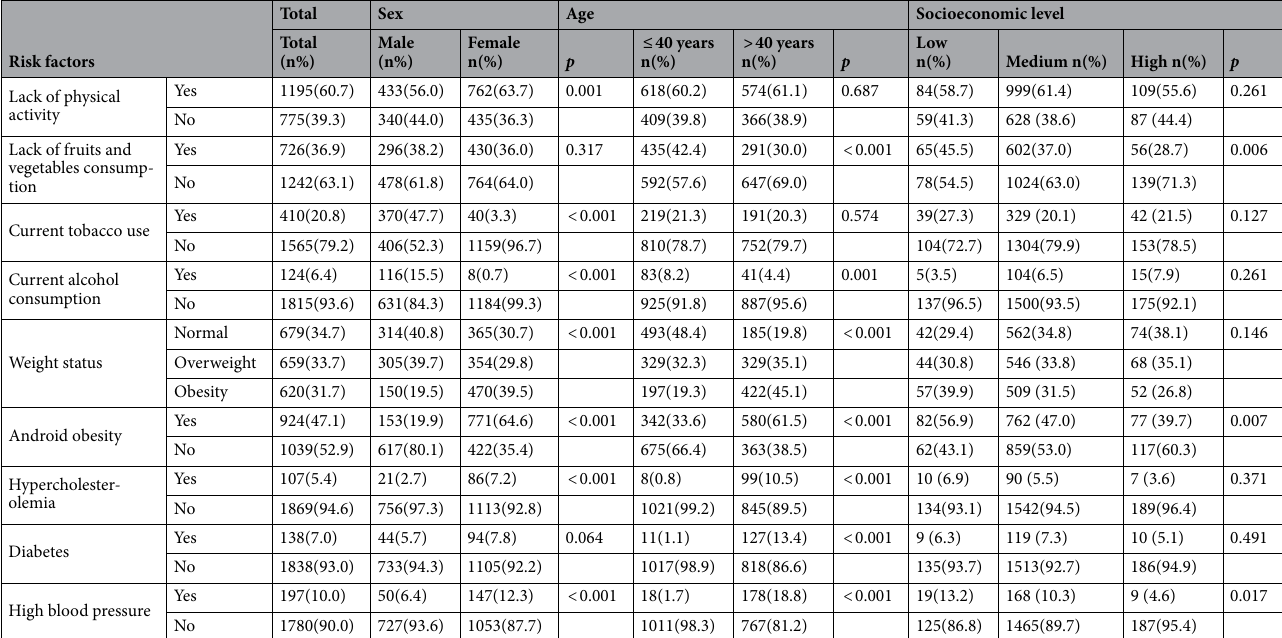
Table 1. Prevalence of cardiovascular risk factors among participants according to the sex, the age group and the socioeconomic level.